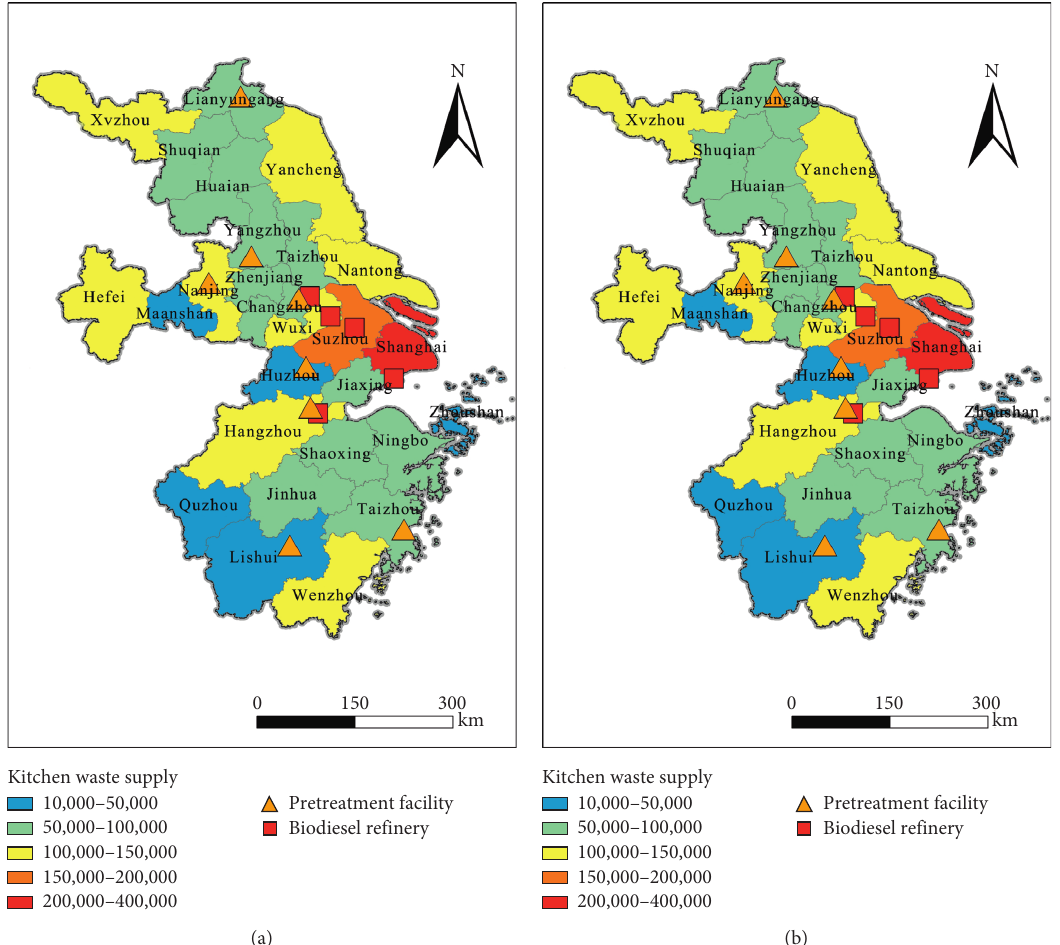
Figure 11: Network structure sensitivity analysis of kitchen waste residual value. (a) Residual value of 0 Yuan/ton. (b) Residual value of 120